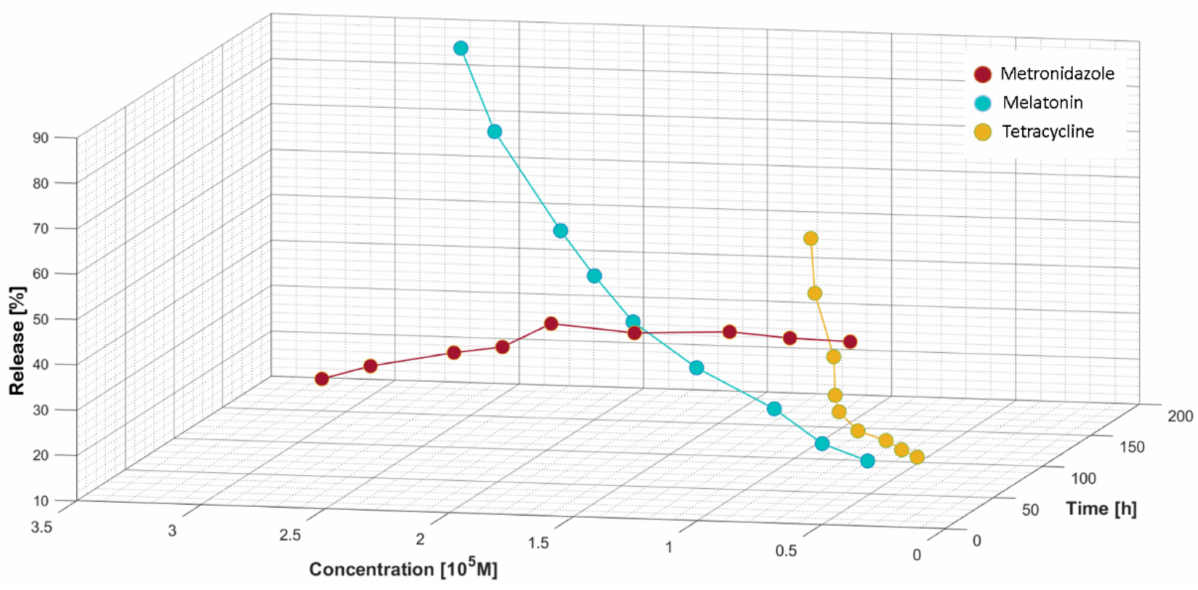
Figure 9. Release ratio (%) versus concentration of bioactive components and